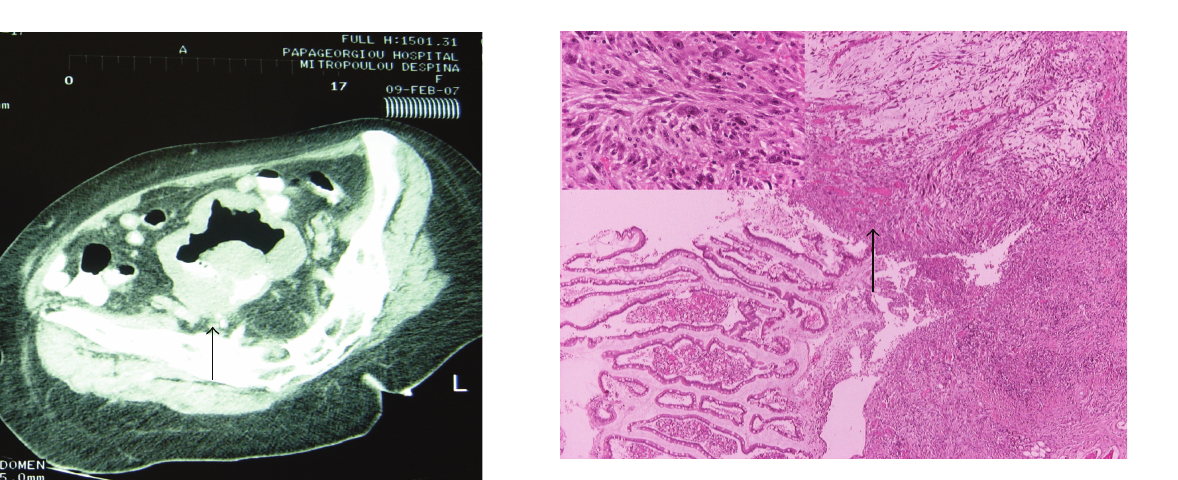
Figure 4: Microscopy with H and E staining × 40, left up ×